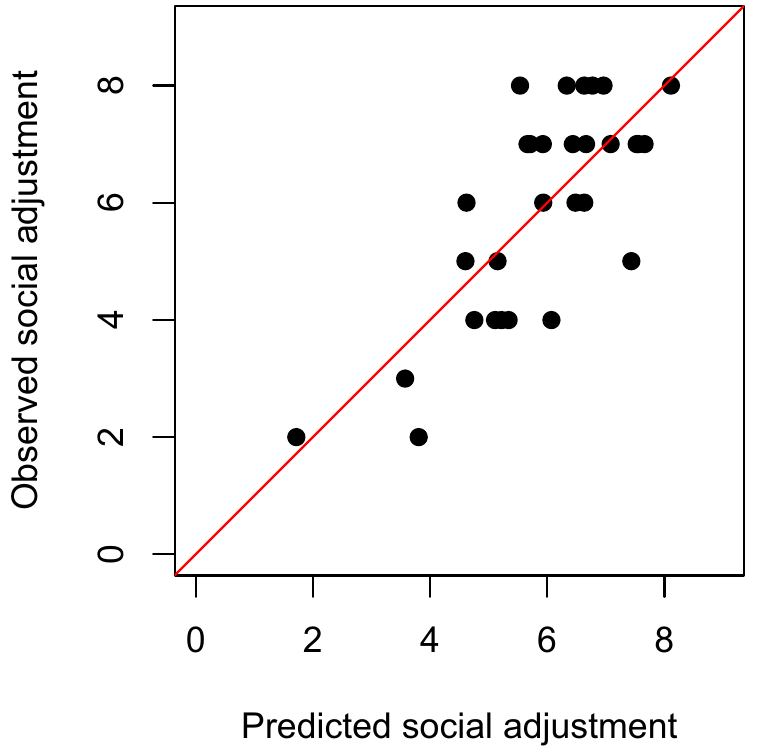
Fig 2. Regression plot of the final regression model. Regression plot of the final regression model (adjusted R 2 = 0.507), including SWS ( β = 0.317; p = 0.035) and hospitalizations ( β = -0.482; p = 0.003) as significant predictors. Verbal memory (VLMT; β = 0.224; p = 0.160) and symptom severity are non-significant predictors of the model ( β = -0.209; p = 0.229).